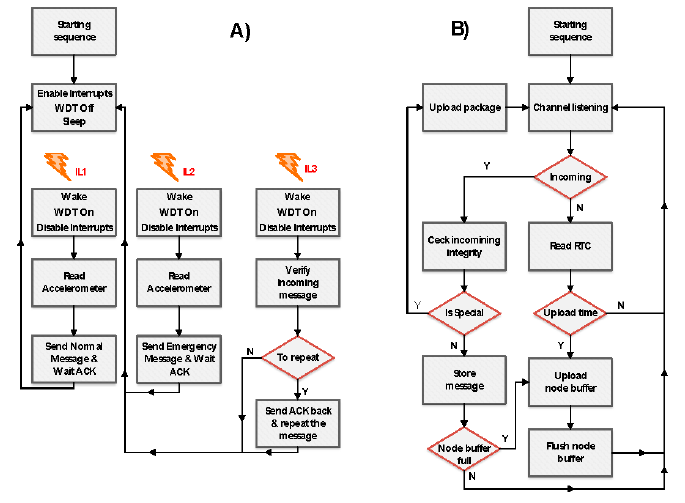
Figure 2. Node/Repeater ( A ) and data logger ( B ) ASM diagram.